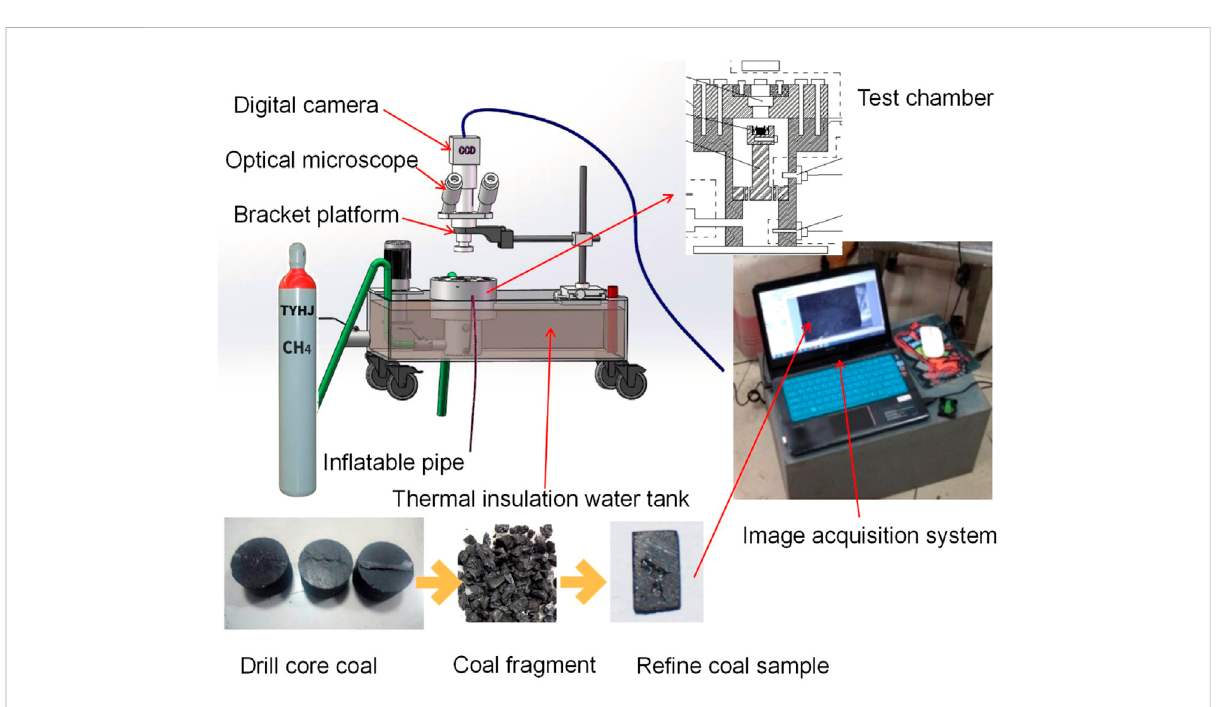
FIGURE 2 A new device for measuring adsorption-induced